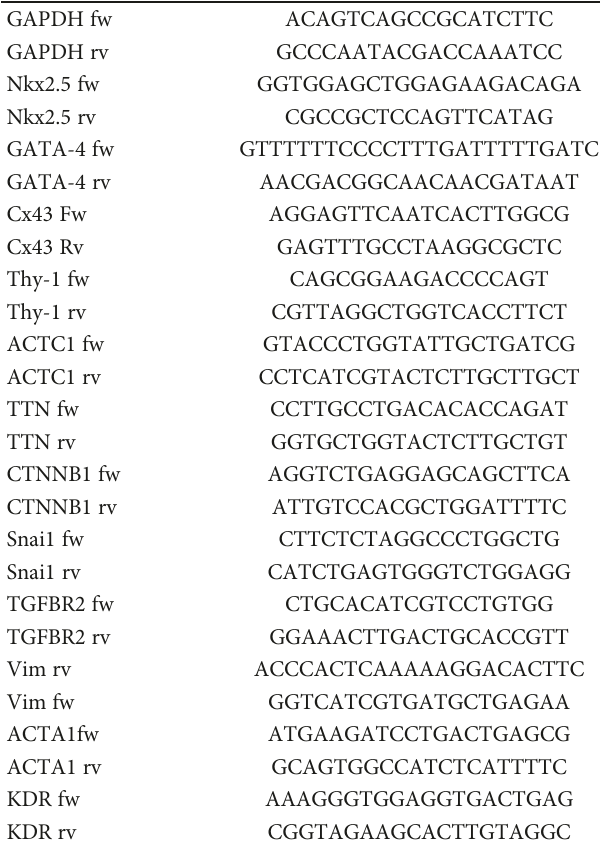
Table 1: Primers used for qPCR